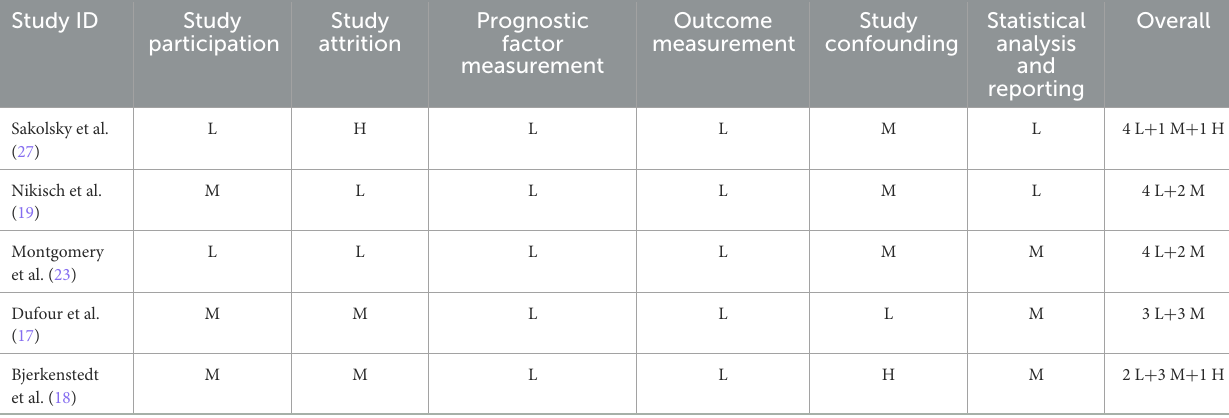
TABLE 3 Quality assessment of the prognosis